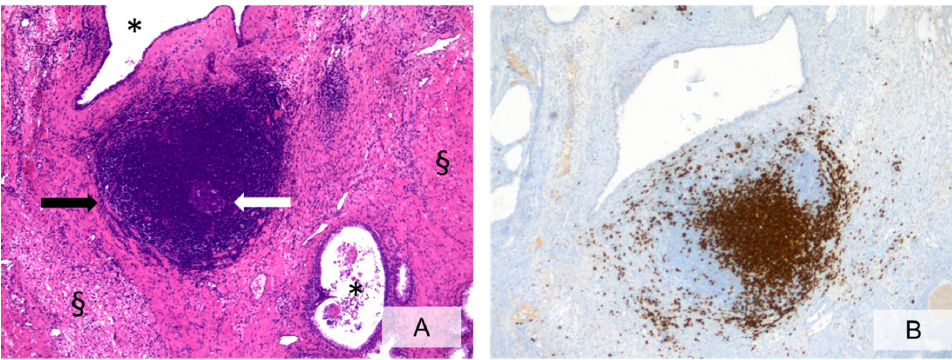
Figure 1. Prostatic stroma showing marked focal chronic inflammation with lymphoid follicle 178 formation ( A , H&E, ×10, black arrow = lymphoid follicle; white arrow= germinal center; * = prostatic 179 glandular lumina; §= prostatic stroma;). Immunohistochemical staining for anti-CD20 ( B , ×10) and 180 anti-CD3 ( C , ×10) highlights the B-cell and the T-cell compartments, respectively. Anti-CD21 staining 181 ( D , ×10) identifies the follicular dendritic cell meshworks in germinal centers.